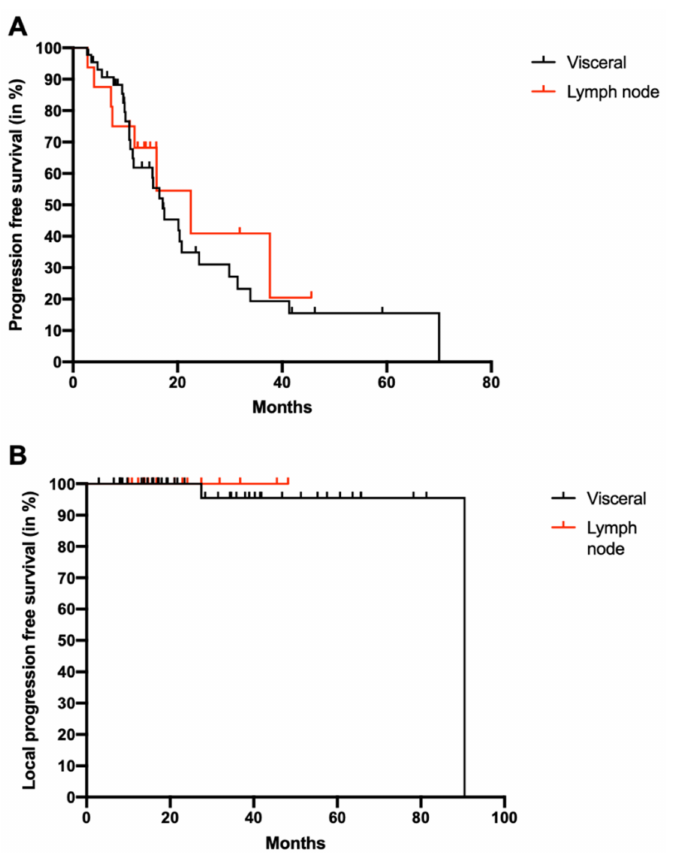
Figure 1. Progression free survival and local tumor control after RRS. ( A ): Progression free survival was calculated for patients with lymph node metastases (red) and visceral metastases (black) treated with RRS therapies. ( B ): Local progression free survival was determined as recurrence within the area of the RRS. Again, patients with lymph node metastases (red) and visceral metastases (black) treated with RRS therapies were analyzed separately. RRS: robotic radiosurgery.